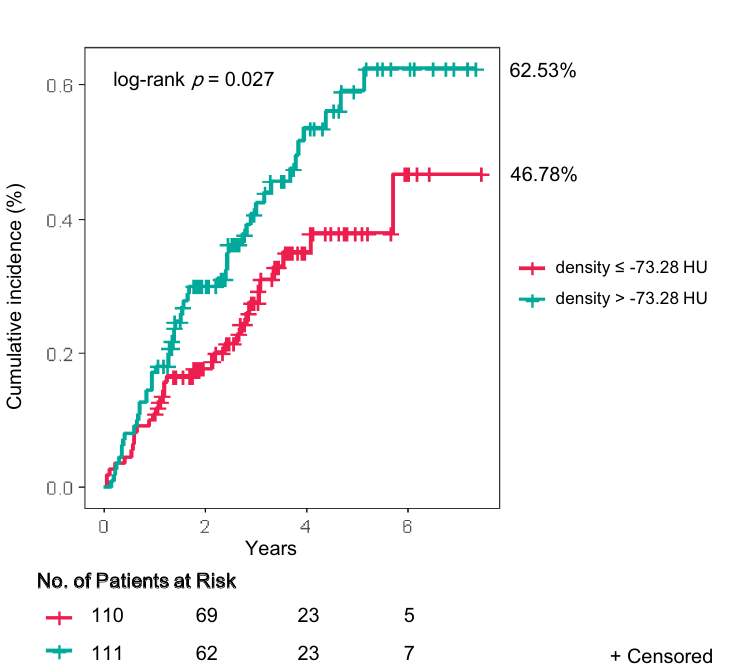
Figure 1. Comparison of the risks factors for all-cause mortality between the high and low EAT radiodensity groups. EAT epicardial adipose tissue, HU Hounsfield unit.